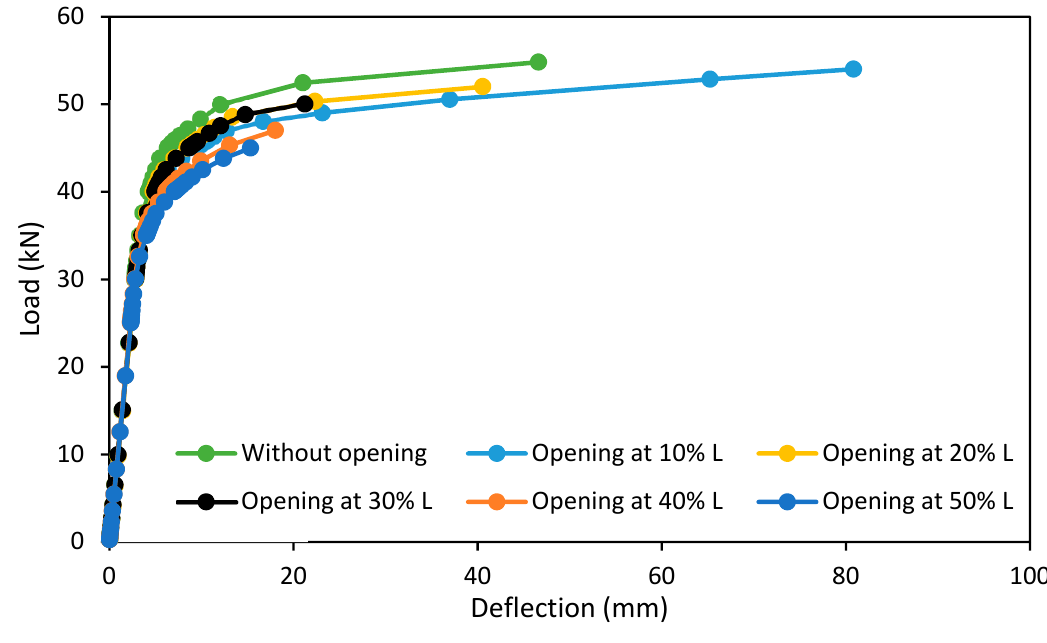
Figure 12. Load ‐ deflection curve of the first group specimens in parametric case studies. Figure 12. Load-deflection curve of the first group specimens in parametric case